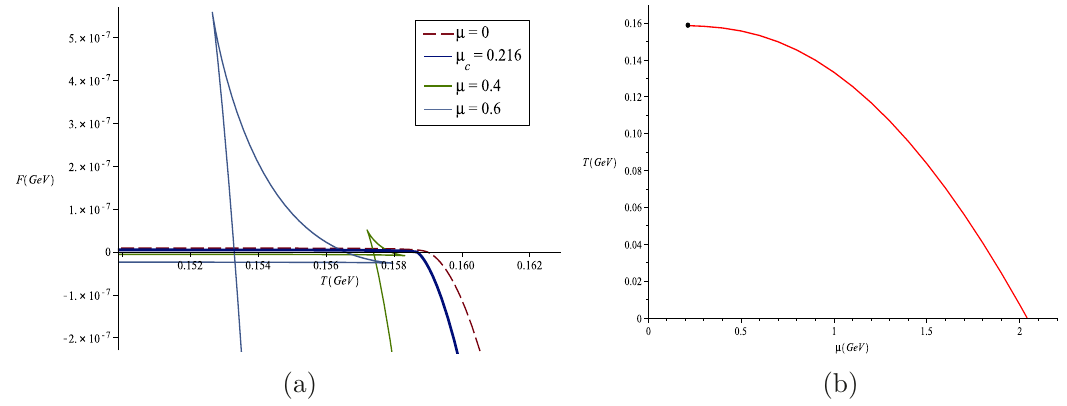
Figure 3 . (a) The free energy vs. temperature at different chemical potentials. (b) The phase diagram in T µ plane. The red line represents the first order phase transition and the black dot − labels the critical endpoint at ( µ c , T c ) (0 . 216 , 0 . 159). The zero temperature phase transition is ≃ located at µ T =0 2 . 039. ≃